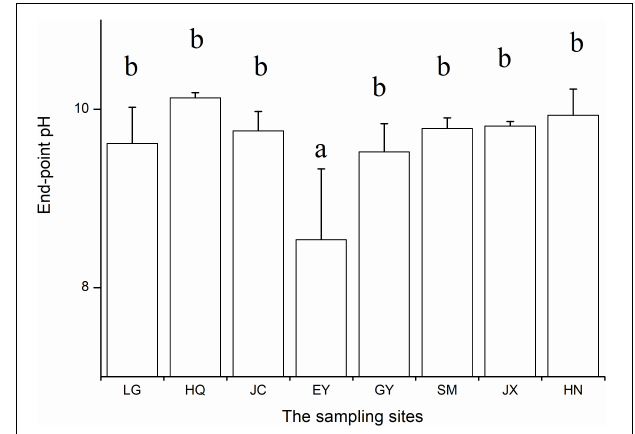
FIGURE 1 | The end-point pH of the pH-drift experiments in the eight